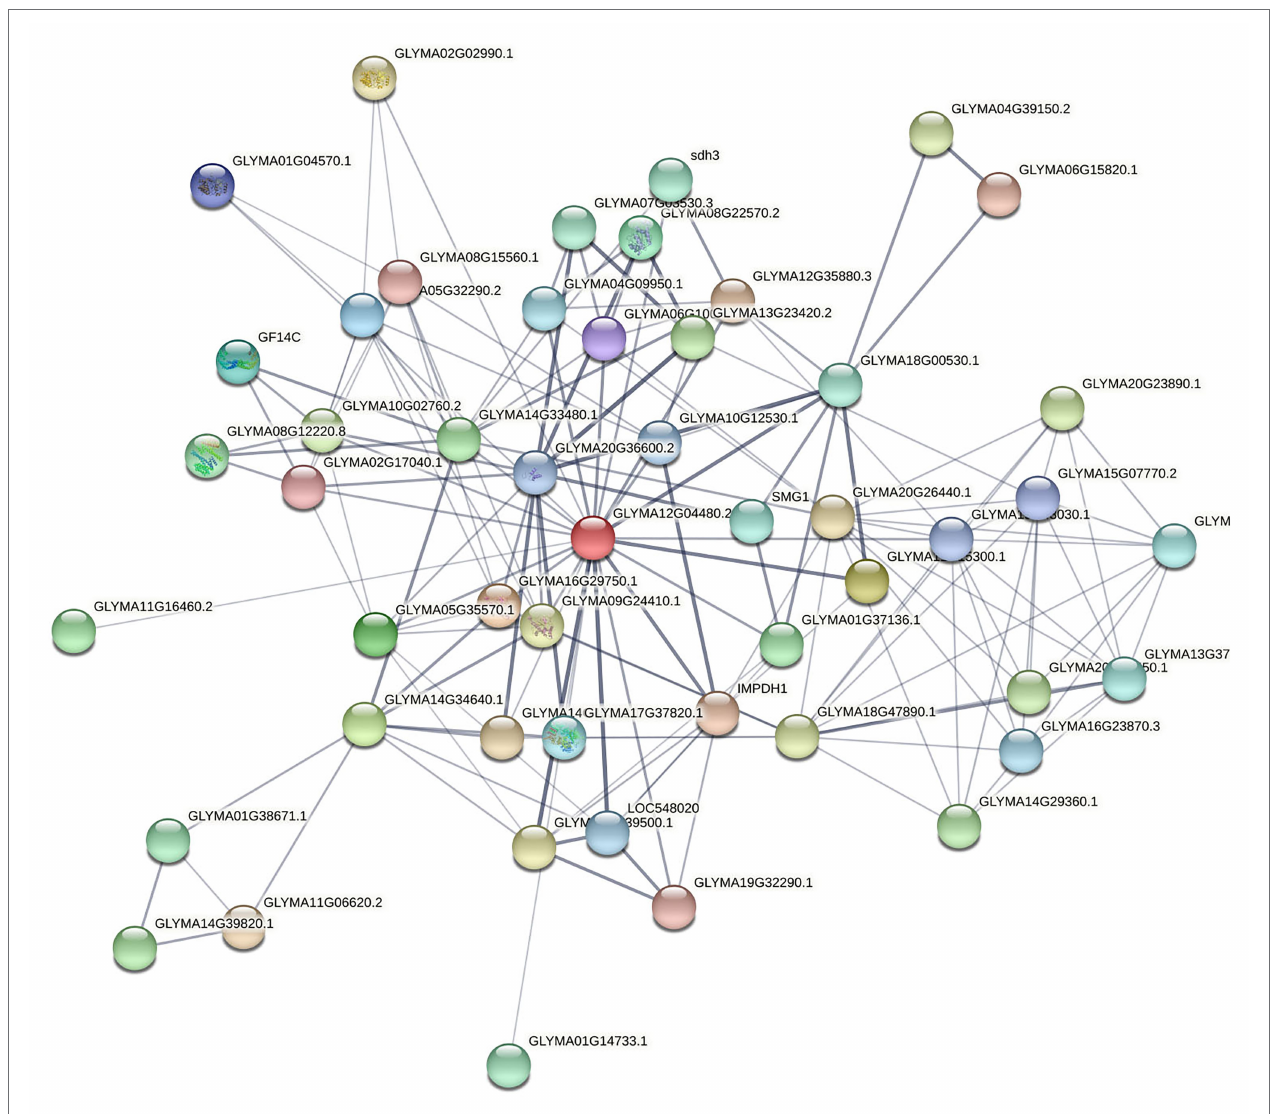
FIGURE 7 | Core nodes targeting soybeans screened by PageRank algorithm. Here, the confidence line type was selected, where the nodes in the figure represent the proteins targeted to soybeans, and the connections between the nodes represent the interaction relationships between the proteins. Thickness indicates the strength of the interaction between